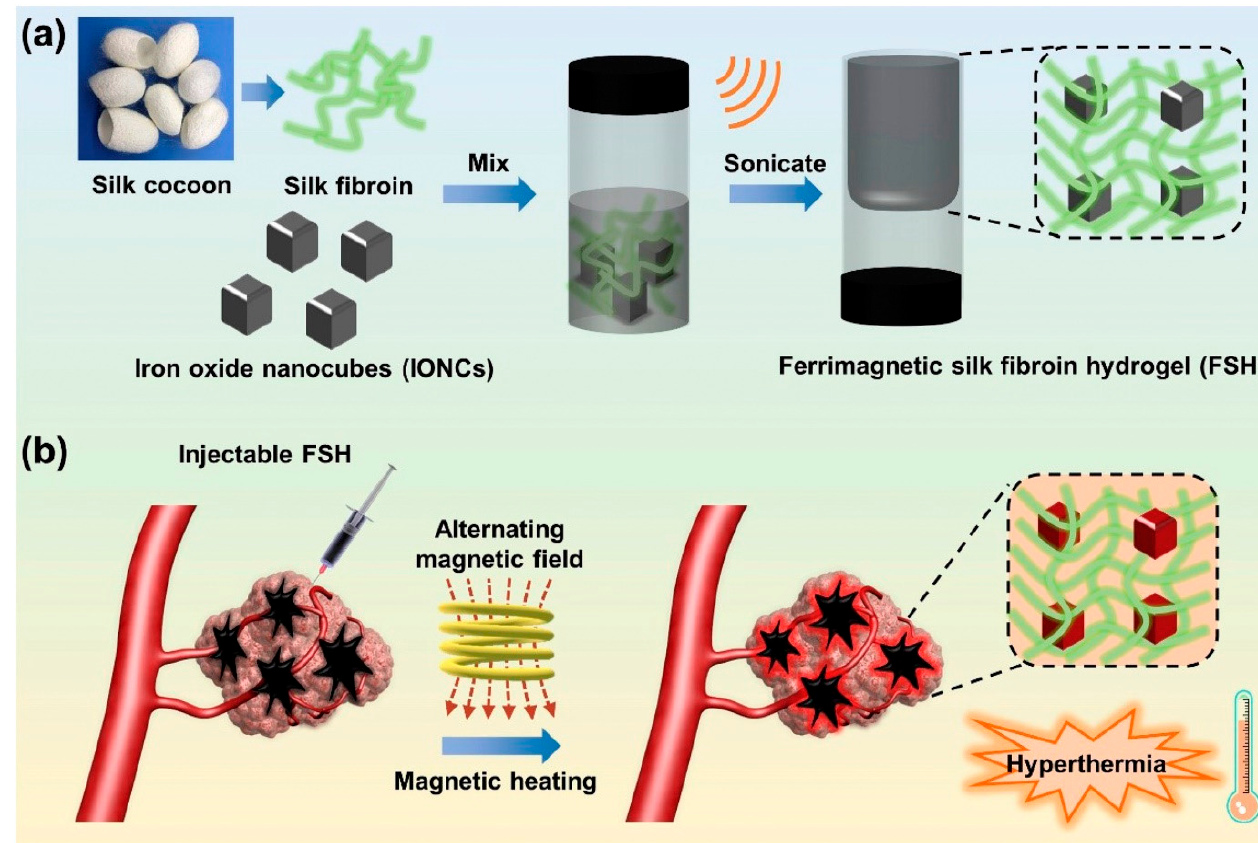
Figure 9. ( a ) Fabrication of a ferrimagnetic silk fibroin hydrogel by the physical attachment of PEG-stabilized iron oxide nanocubes and silk fibrion. ( b ) Prepared injectable hydrogel for liver-targeted thermoablation [134] © 2021 Elsevier.